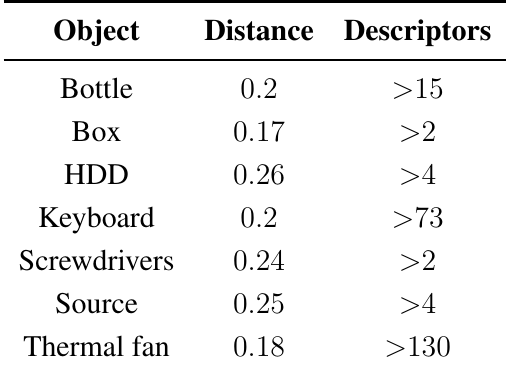
Table 2. Values used to discriminate objects based on